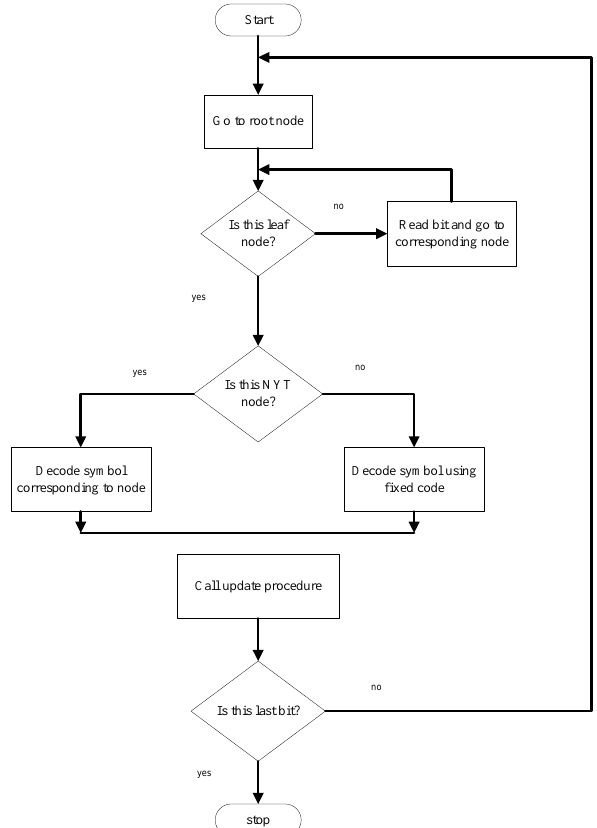
Figure 7. Adaptive Huffman decoding procedure